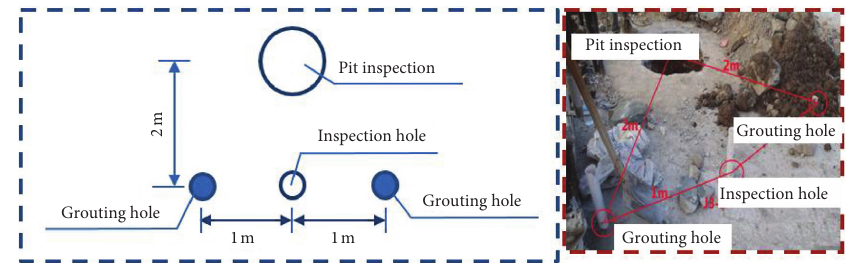
Figure 5: Setup of the on-site grouting reinforcement